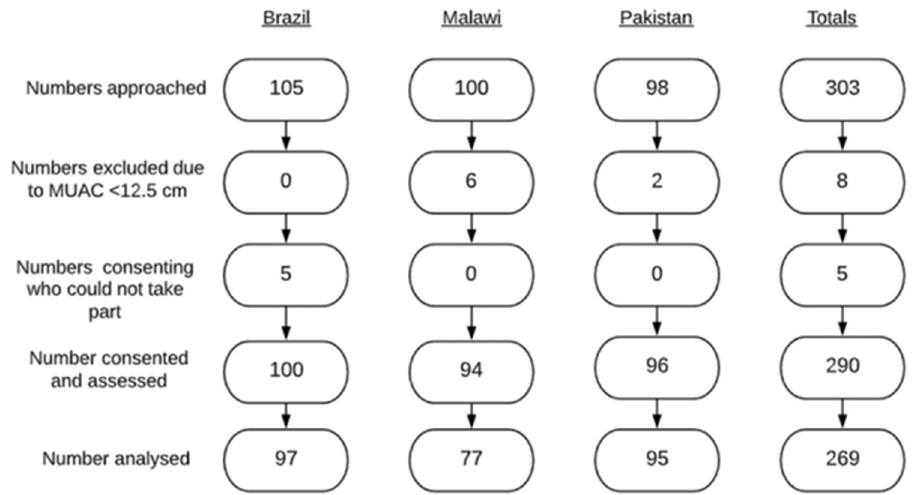
Figure 1. Flow chart demonstrating recruitment to IYCD validation study.